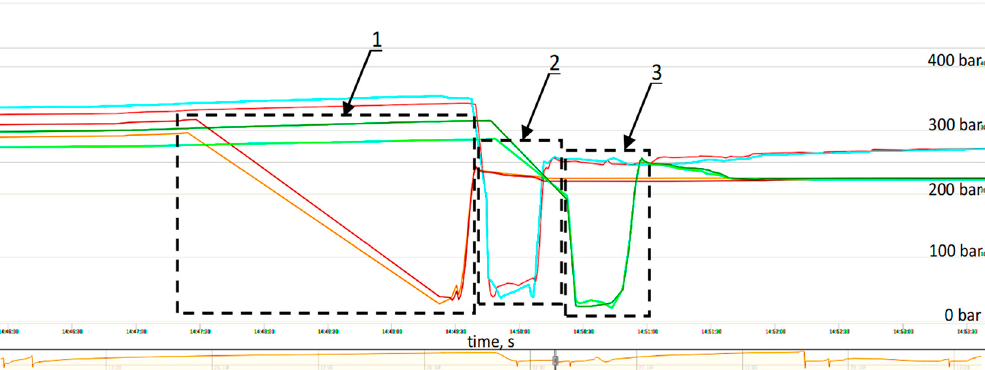
Figure 9. The pressure value progress after installing the automatic expansion system for the selected powered support: 1, working time of powered support no. 43 is 131 s; 2, working time of powered support no. 44 is 32 s; 3, working time of powered support no. 45 is 34 s.